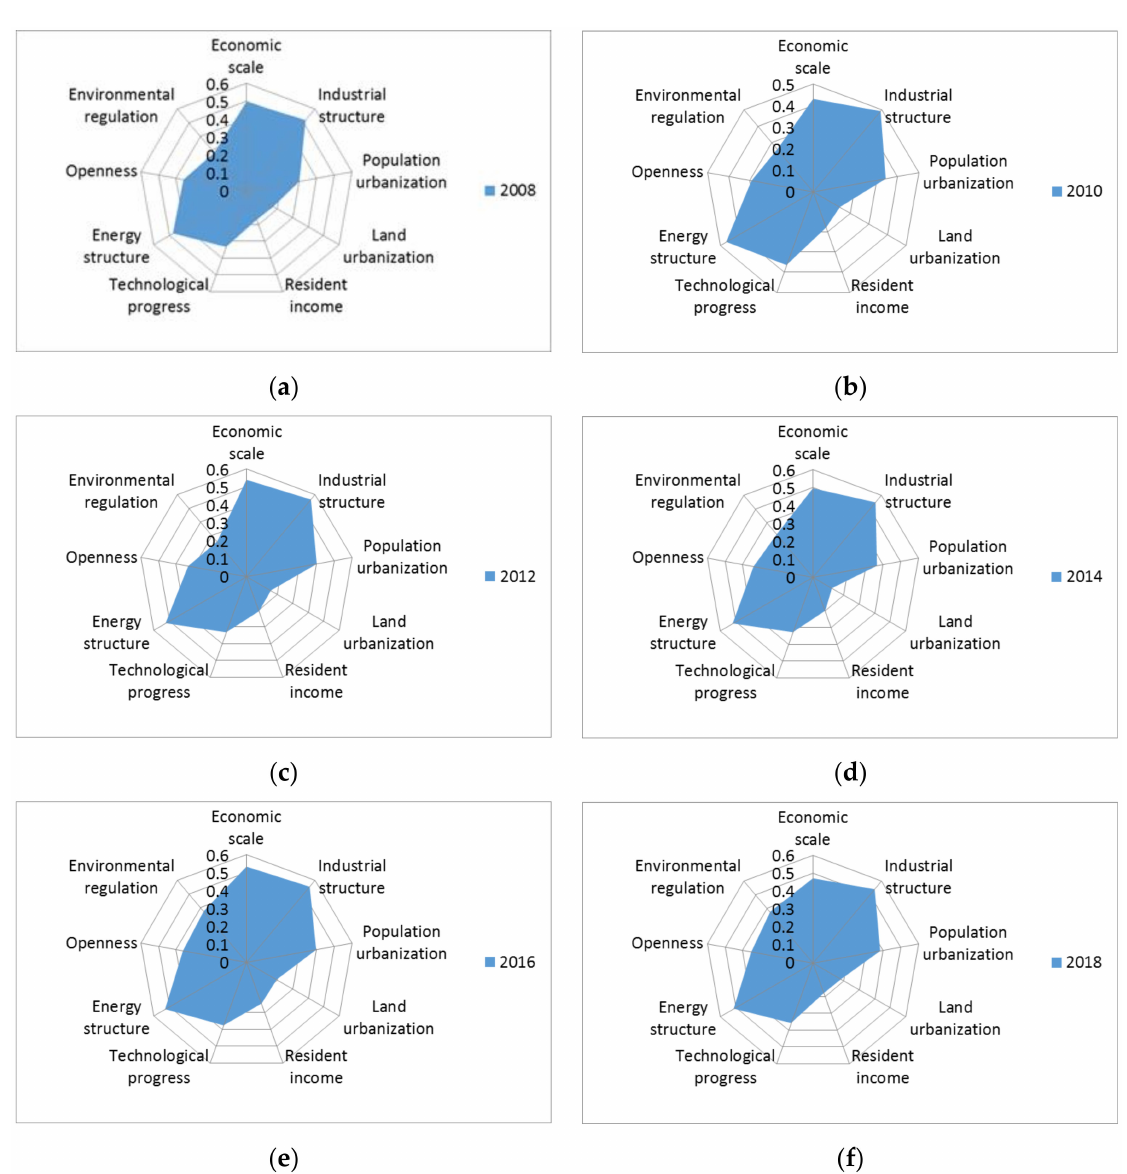
Figure 4. The influential factors of UCEs in China from 2008 to 2018. ( a ) 2008; ( b ) 2010; ( c ) 2012; ( d ) 2014; ( e ) 2016; ( f ) 2018. Note: All the results passed the 1% significance test. This figure shows only the results of even years, and the results of odd years can be seen in Supplementary